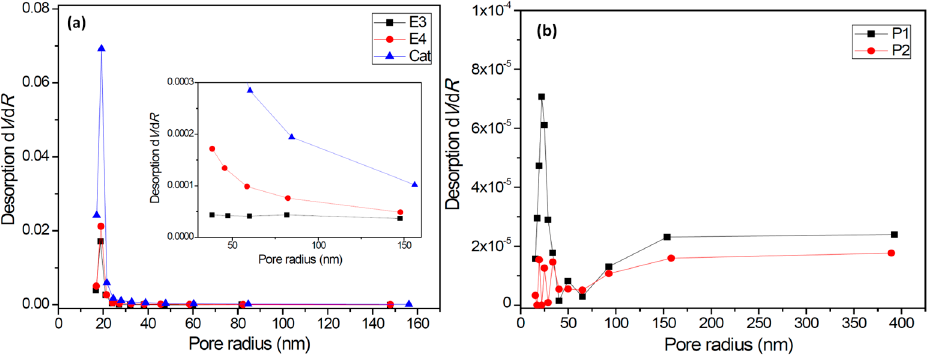
Figure 5. Pore size distributions of the catalyst and the polymer/catalyst particles. ( a ) Polyethylene/catalyst and catalyst and ( b ) polypropylene/catalyst.